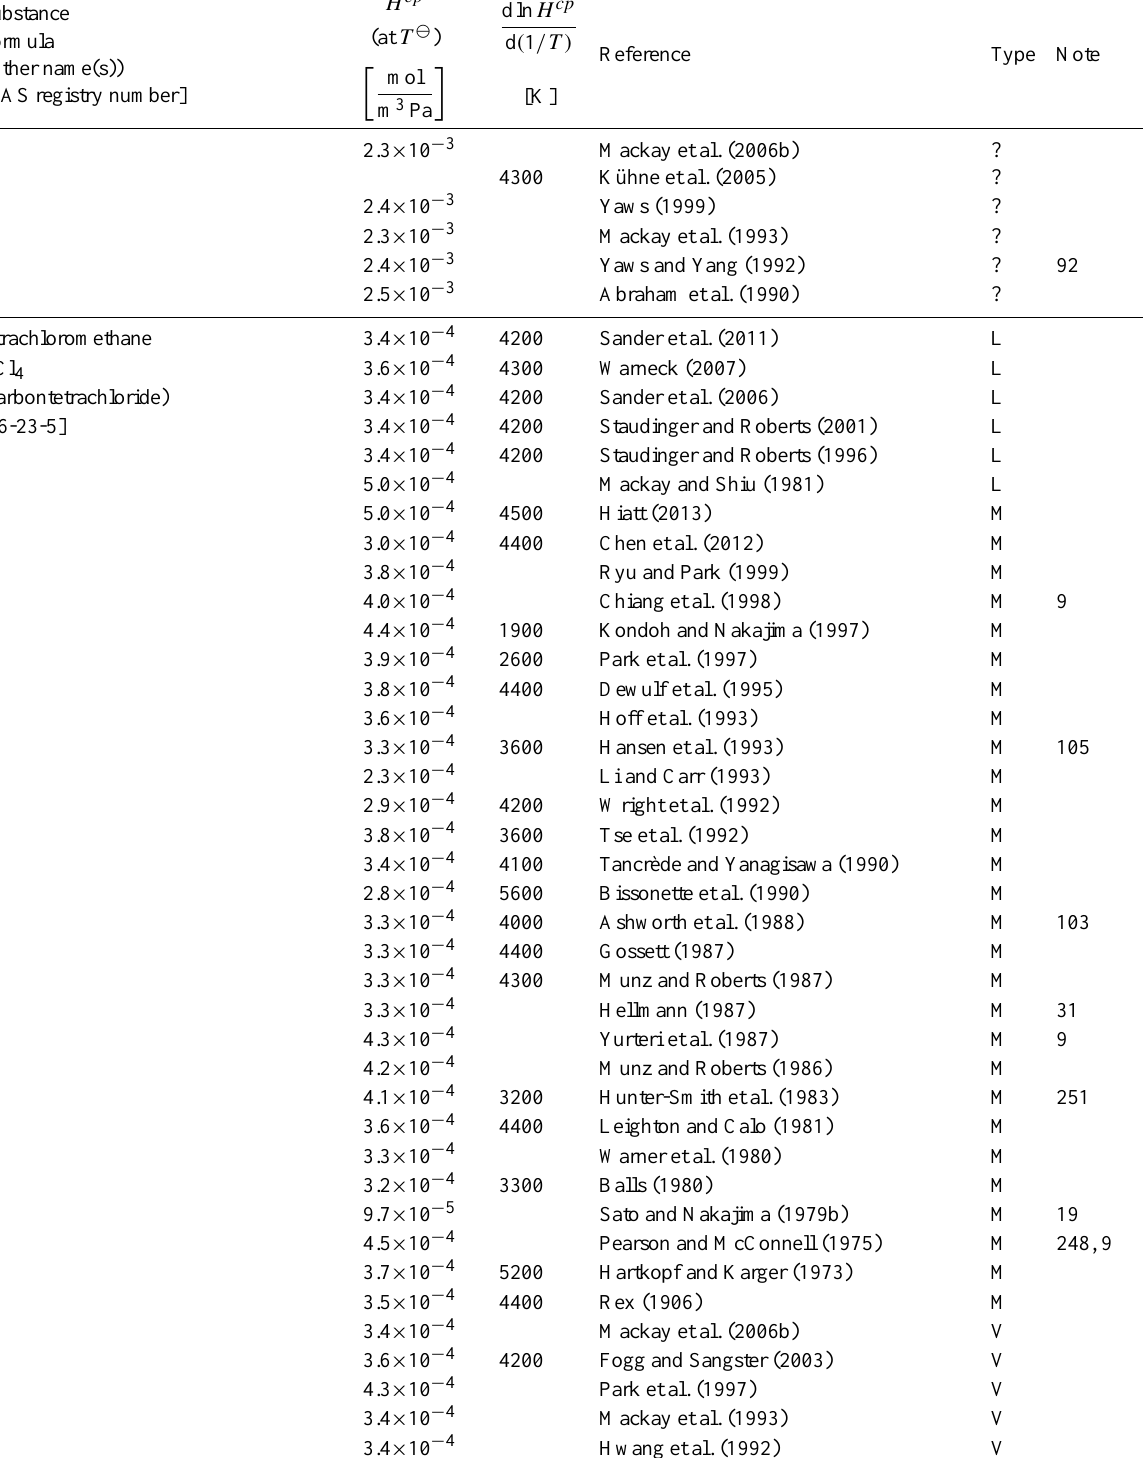
Table 6: Henry’s law constants for water as solvent